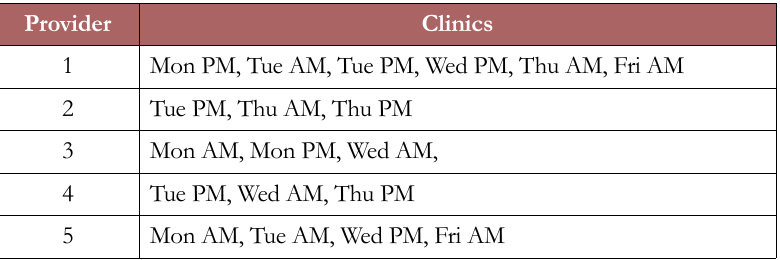
Table 3. Oncologists’ weekly